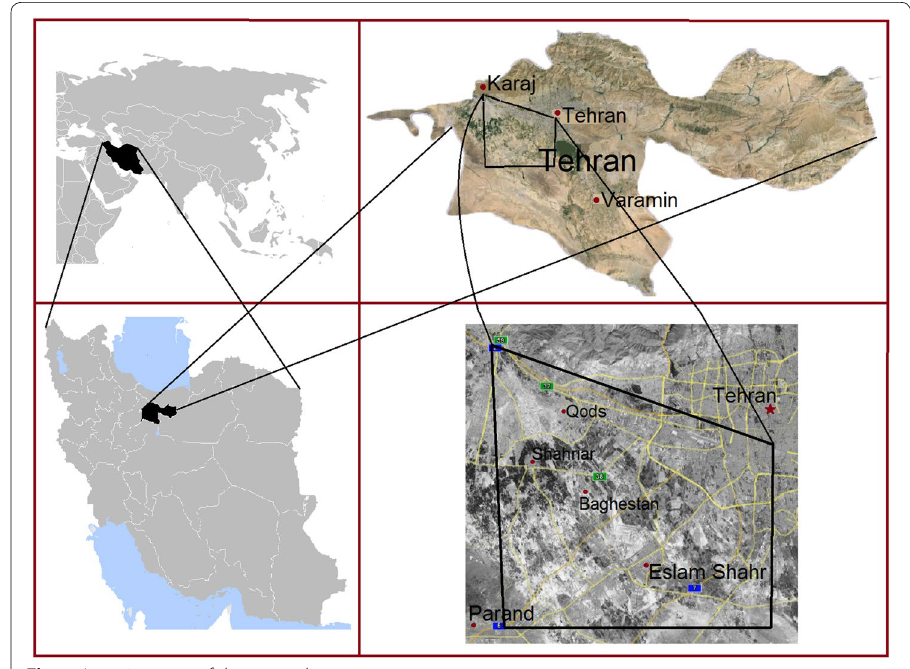
Fig. 1 Location map of the research